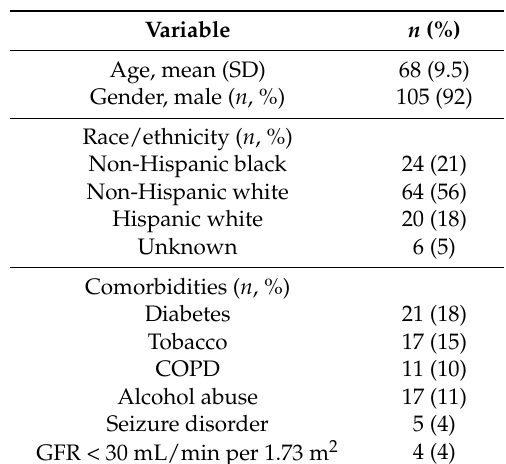
Table 1. Demographics, n = 114 low trauma fractures.